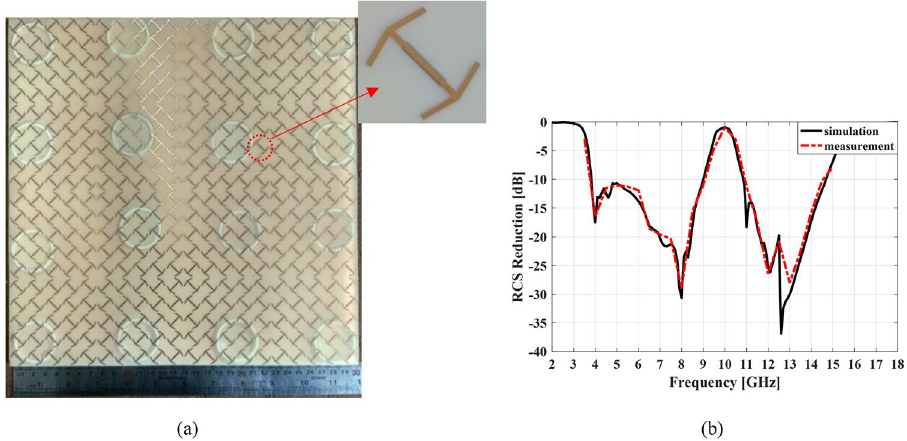
Figure 16. ( a ) The prototype of proposed meta-mirror, ( b ) simulation and measurement results of the proposed meta-mirror versus frequency for normal